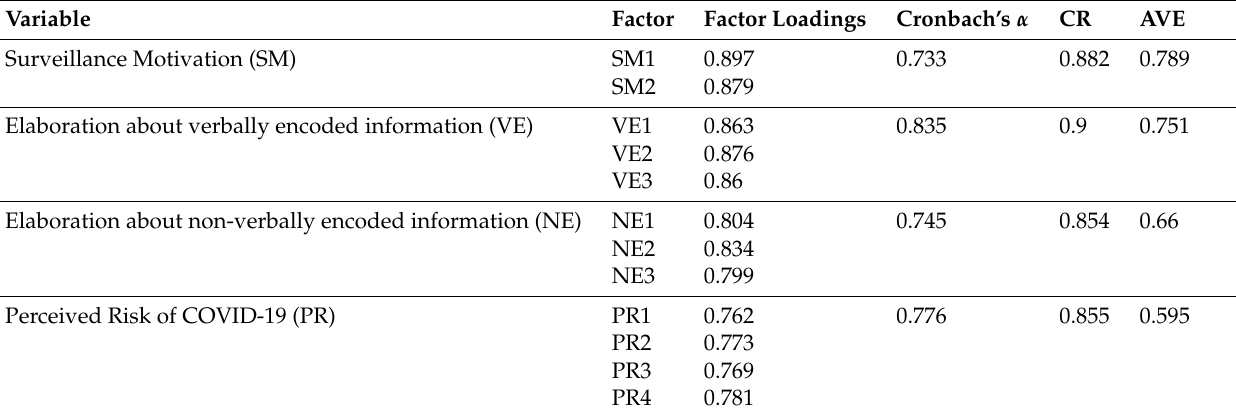
Table 3. Reliability and convergent validity.